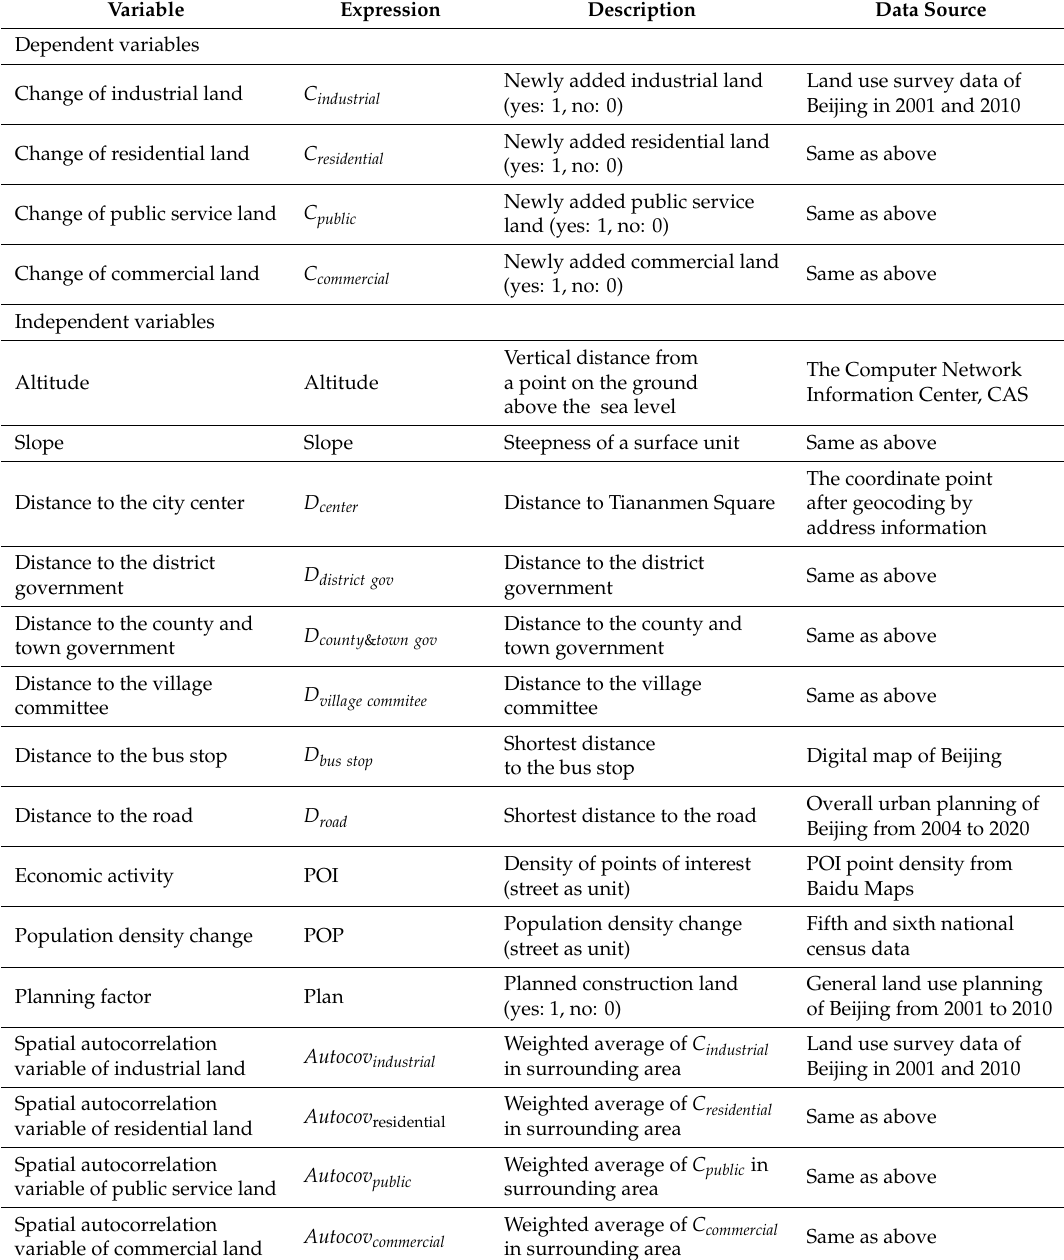
Table 1. Variables and data